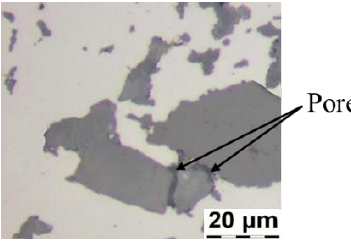
Figure 16. Pores generated within the matrix of the 20% ZrO 2 layer owing to particle cluster formation [39].